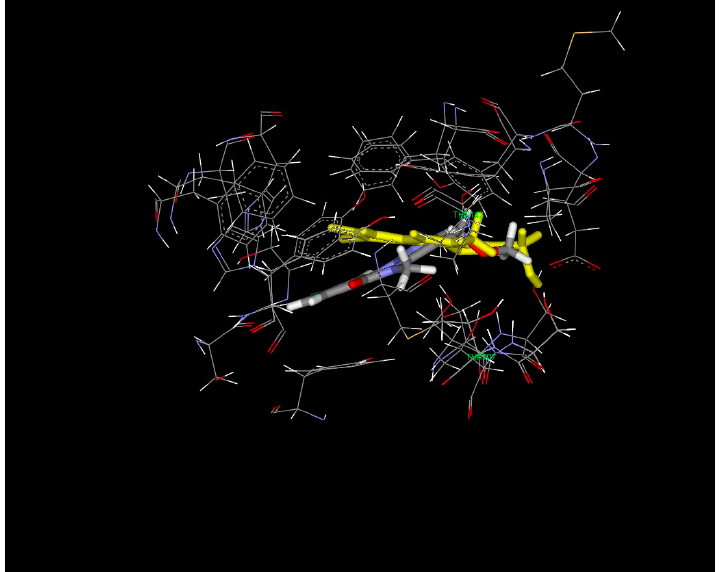
Figure 2. Superimposition of compounds 18 (yellow) and 19 .